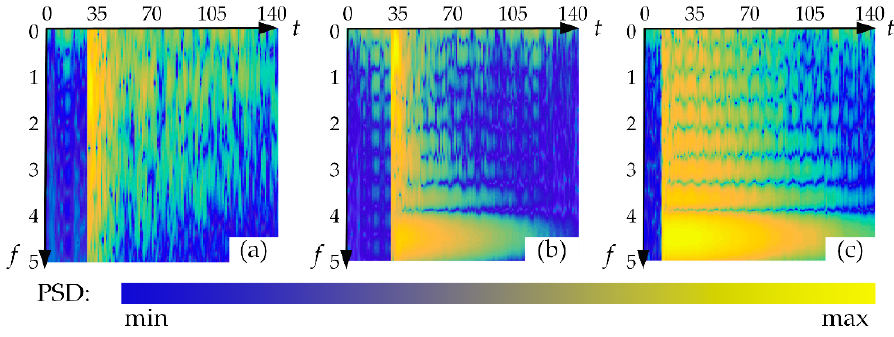
Figure 4. Examples of spectrograms. The rebound values of ( a ), ( b ), and ( c ) are 20, 54, and 73 respectively. The horizontal axes represent time (/ms), and the vertical axes are frequencies (/kHz).